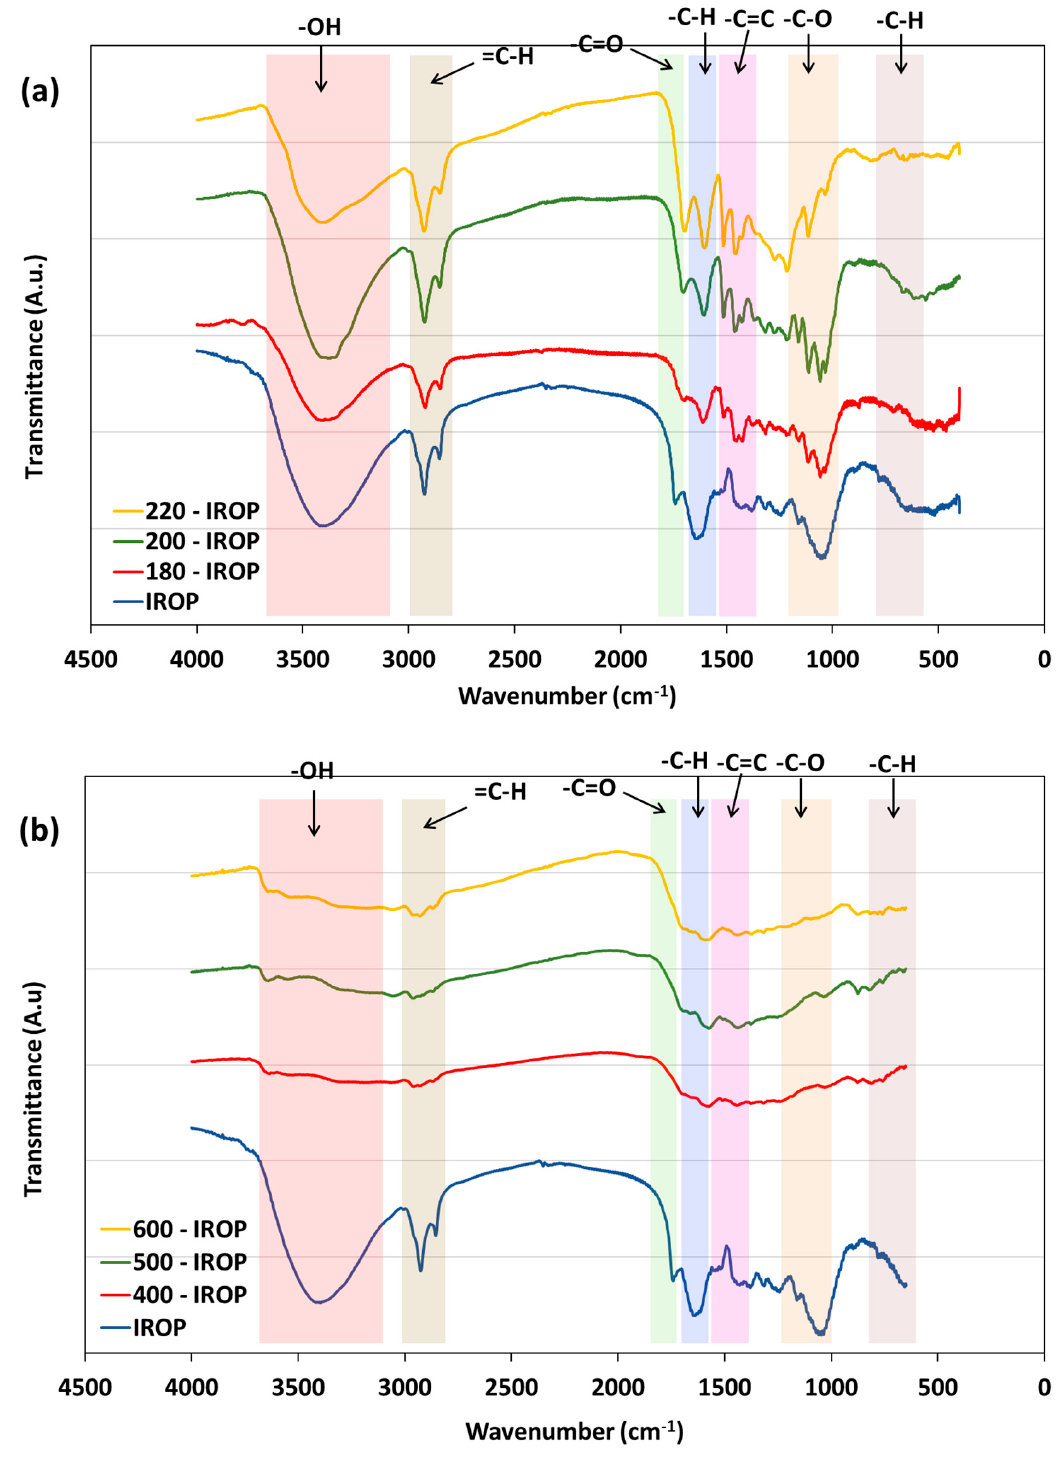
Figure 5. Fourier transform infrared spectroscopy for IROP and the resulting ( a ) hydrochars and ( b ) biochars produced at 180, 200, 220 °C and 400, 500 and 600 °C, respectively .